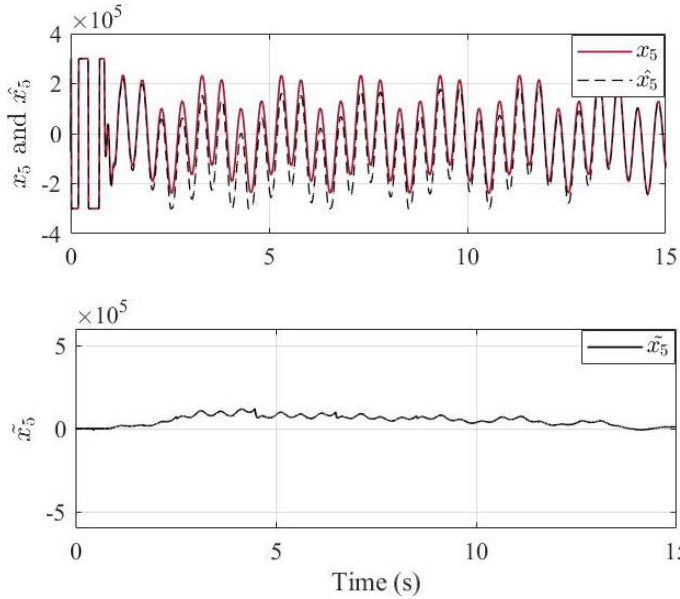
x and estimation error. 5